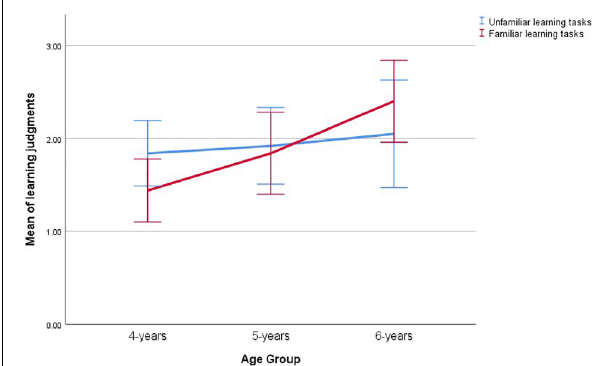
FIGURE 1 | Children’s learning judgments in study 1 across age groups (error bars representing 95% CIs).